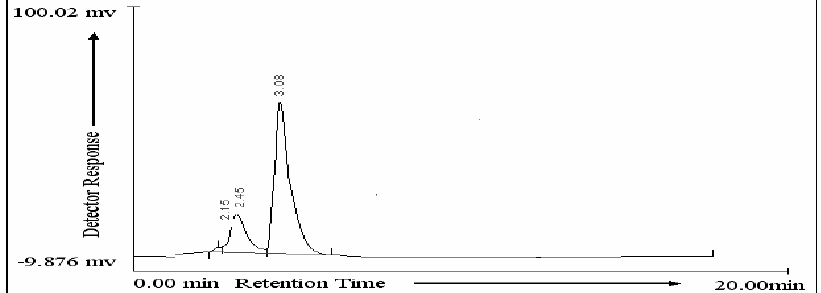
Figure 7. Chromatogram showing thermal degradation